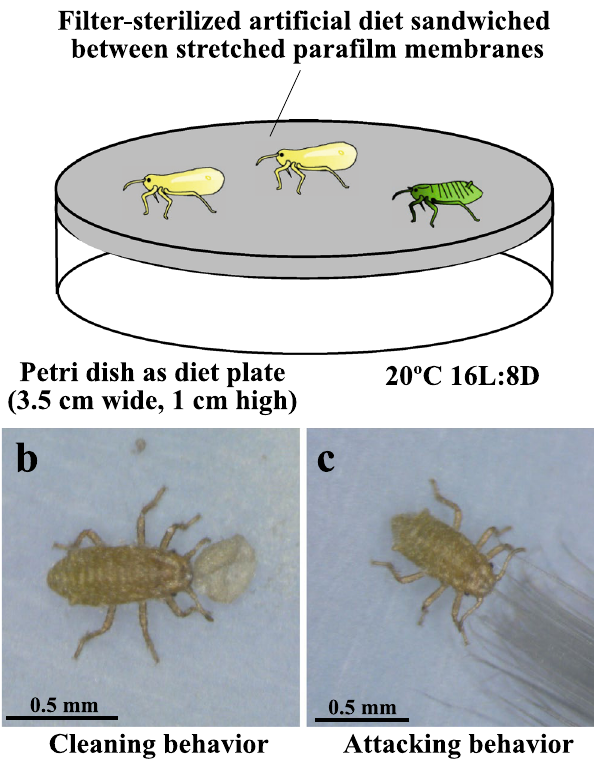
Figure 1. ( a ) Artificial diet rearing system for T. styraci after Shibao et al. 33 . ( b , c ) Behavioral assays for cleaning behavior ( b ) and attacking behavior ( c ) on artificial diet